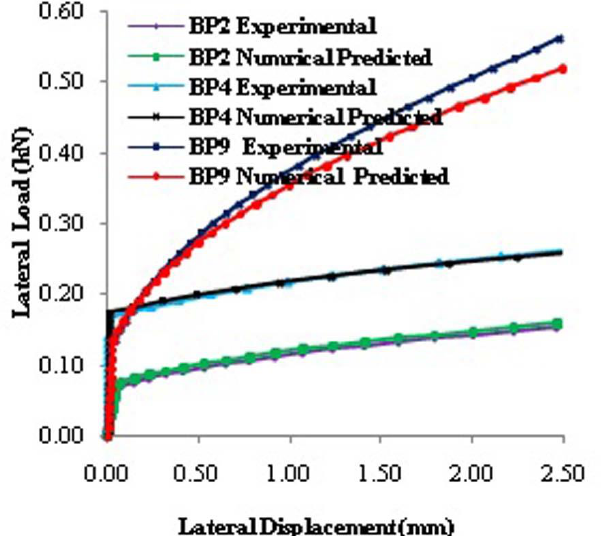
Fig. 8. Comparison between the experimental and predicted lateral load results at 3D pile spacing of bamboo pipe piles in dense sand layer for slenderness ratio as